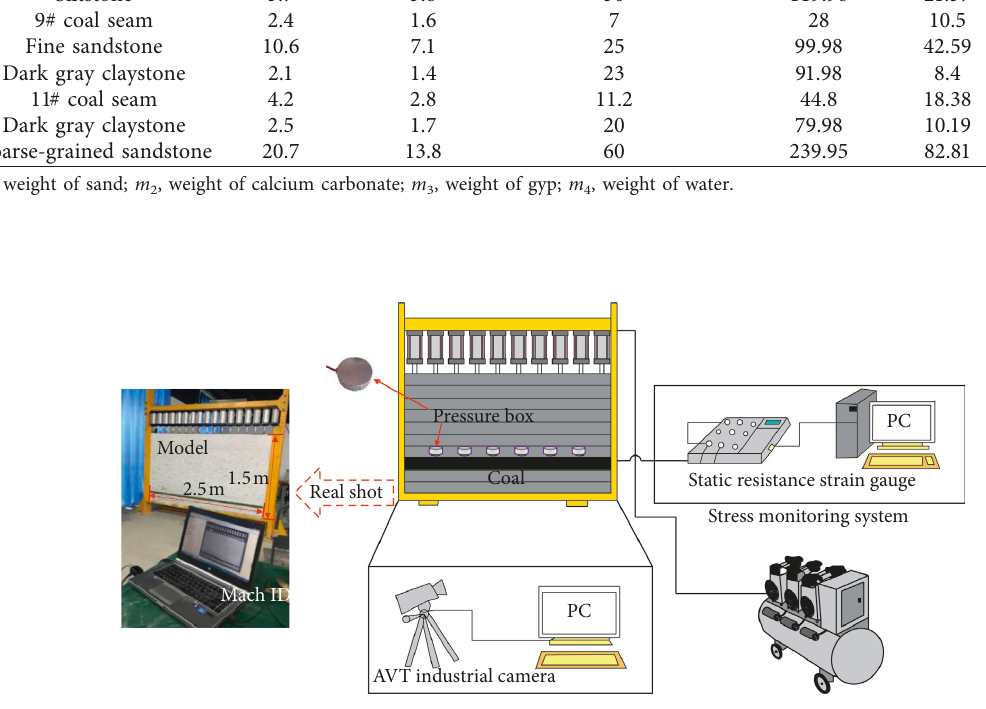
Figure 5: Simulation experiment